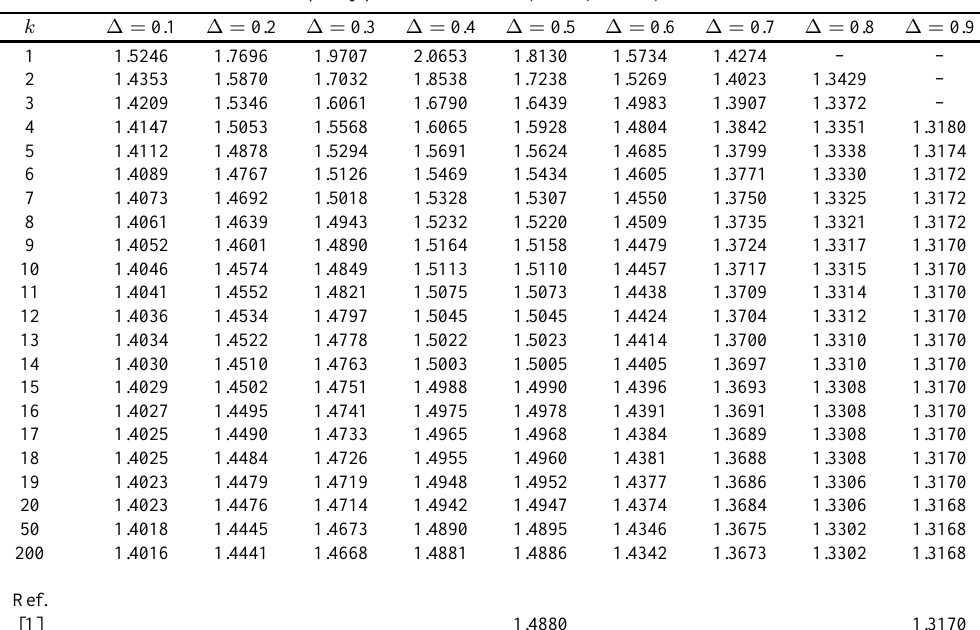
Table 6 Frequency parameter λ (Case 2, c = 1, d = 15,